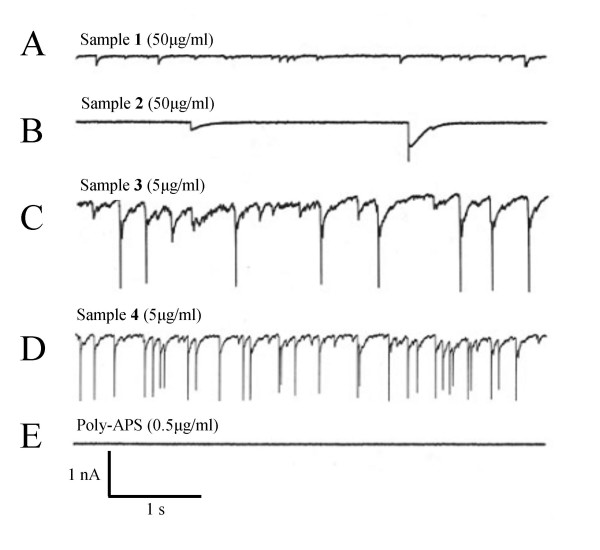
Poly-APS and the related synthetic compounds produced distinctive electrophysiological activity. 5-second traces of current activity recorded during the application of A) sample 1, B) sample 2, C) sample 3, D) sample 4, and E) poly-APS by low-pressure ejection. A-D, Synthetic compounds 1–4 produced two distinct forms of activity. Activity was not sustained and stable baselines were reached in all cells. Poly-APS produces no spontaneous activity (action currents).